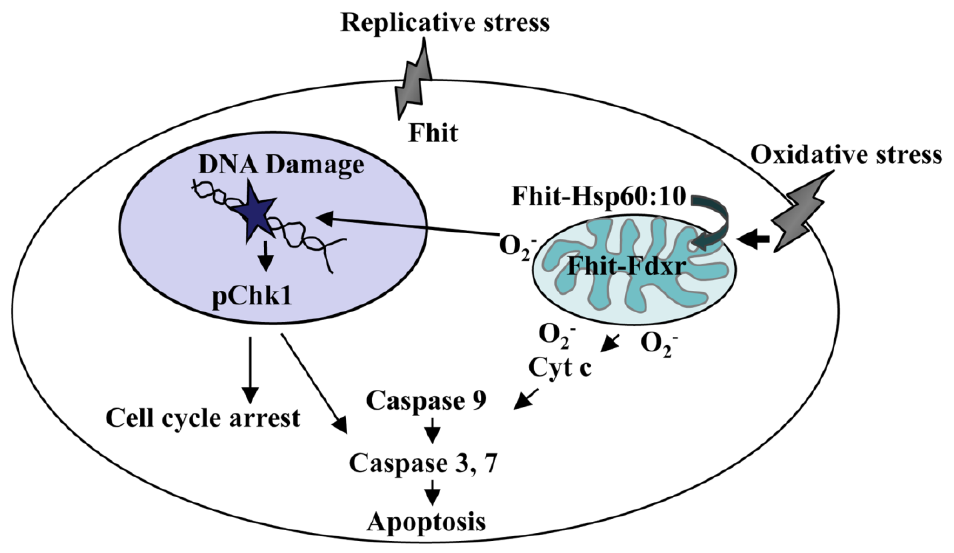
Figure 1. FHIT: suppressor and caretaker. In response to oxidative stress, FHIT protein localizes to the mitochondria via Hsp complex where it interacts with and stabilizes ferredoxin reductase, leading to enhanced production of reactive oxygen species, stimulation of cytochrome c release and subsequent activation of the Caspase cascade under conditions of severe oxidative stress. In response to genotoxic stress, FHIT participates in the checkpoint response to DNA damage via Chk1 to commit cells to cell cycle arrest and, if DNA damage is extensive, to apoptosis. Importantly, FHIT-deficient cells are resistant to oxidative and genotoxic agents and develop preneoplastic